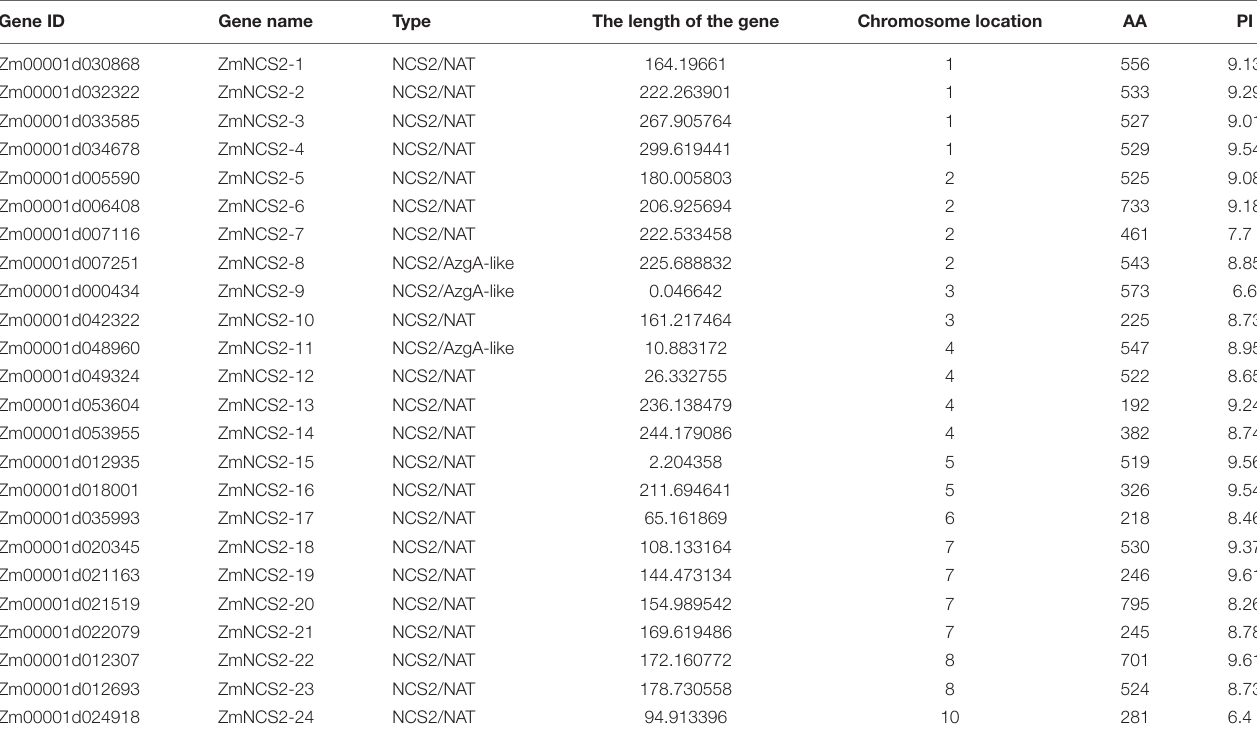
TABLE 1 | Details of the 24 ZmNCS2 genes and their encoded